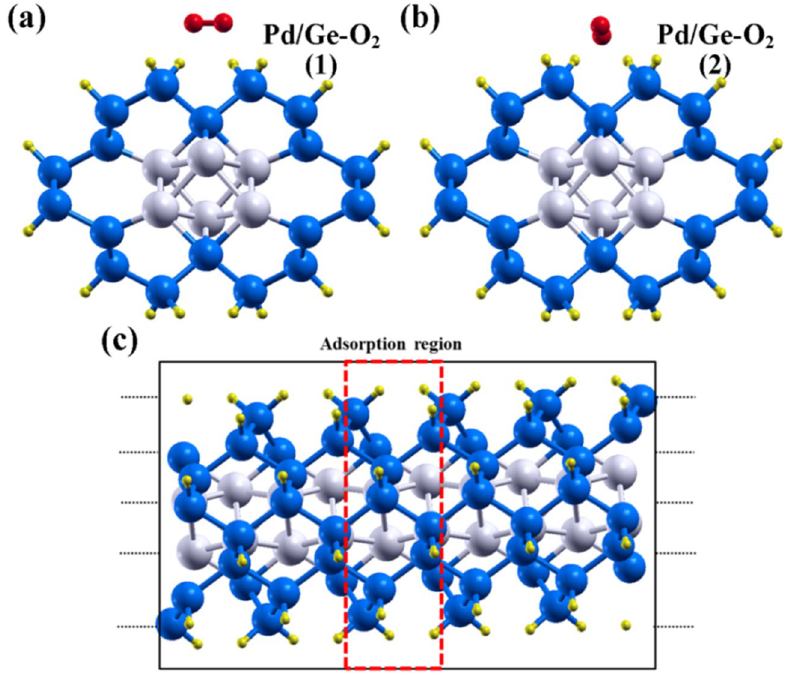
Figure 7. Relaxed O 2 gas molecules on Pd/Ge-NW having configuration ( a ) type 1 geometry and ( b ) type 2 geometry. Schematic view of NW system having 5 primitive cells along the z-axis is shown in figure ( c ).